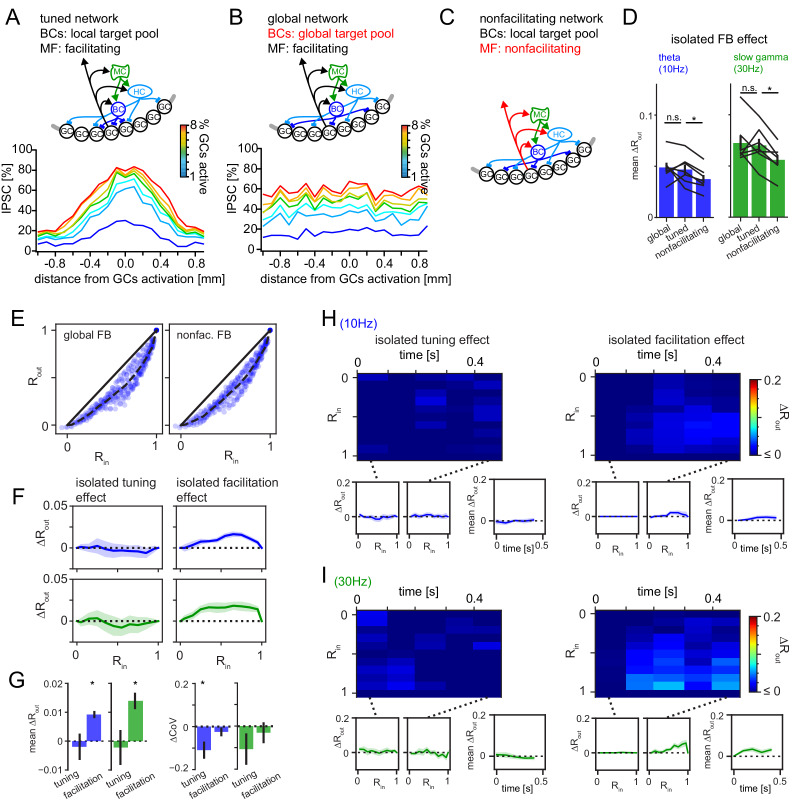
Isolated pattern separation effects of spatial tuning and MF facilitation.Effects of isolated manipulations were computed for the DG model as in Figure 6. (A) Schematic of the full tuned network and the resulting spatial profile of inhibition (as in Figure 5). (B) Schematic of the global network (with unrestricted BC target pool) and the resulting spatial profile of inhibition. (C) Schematic of the non-facilitating network. (D) Isolated mean feedback effects of the global, tuned and non-facilitating models. Two-way RM ANOVA showed: p < 0.001, = 0.020, = 0.402 for frequency, condition and interaction respectively with * indicating significance in Dunnett’s posttest against the full tuned effect. p = 0.742 and 0.020 for global and non-facilitating, respectively at 10 Hz; p = 0.650 and 0.001 for global and non-facilitating, respectively at 30 Hz. (E) Exemplary pattern separation plots of theta modulated inputs when spatial tuning (left) or MF facilitation (right) was removed. (F) Isolated pattern separation effects of the given manipulation for theta (blue) or gamma (green) modulated inputs as a function of input similarity. (G) Isolated effect of the given manipulation on mean ΔRout (left) and the coefficient of variance (ΔCoV) of pattern separation between individual comparisons (right). (H, I) Time-resolved analyses of isolated effects of spatial tuning (left) and MF facilitation (right) for theta (top row) and slow gamma (bottom row) modulated inputs. In each subpanel, the bottom left and middle insets show ΔRout as a function of input similarity of the first and last time windows respectively. The bottom right insets show the evolution of the mean ΔRout over time.